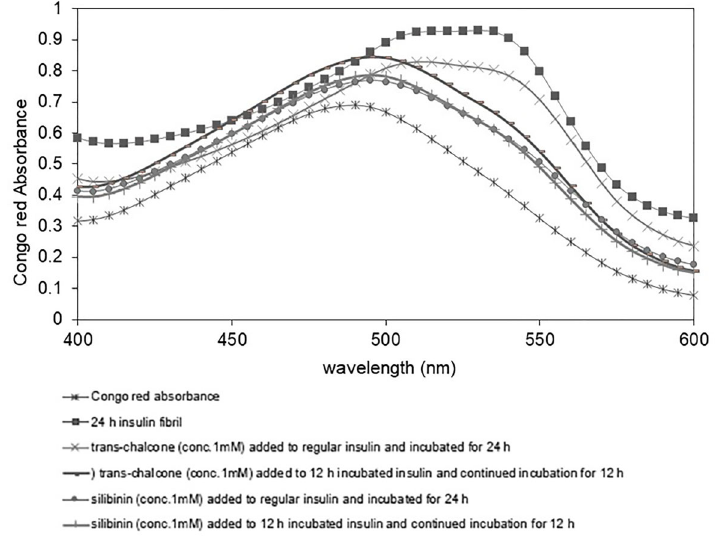
Figure 3. Congo red binding adsorption spectra of regular insulin in the absence and presence of trans- chalcone and